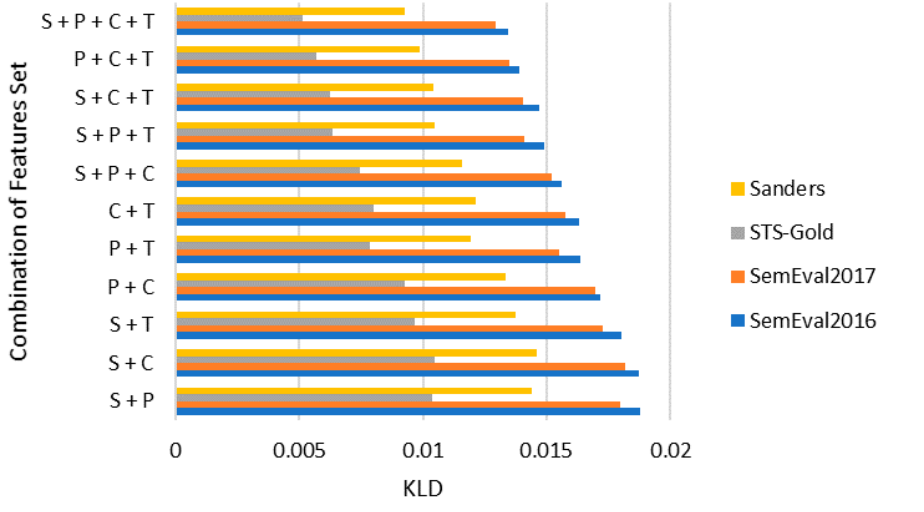
Figure 3. Comparison of combined feature sets performances. Table 7. Comparison of feature sets combination using ML classifiers on SemEval2017.